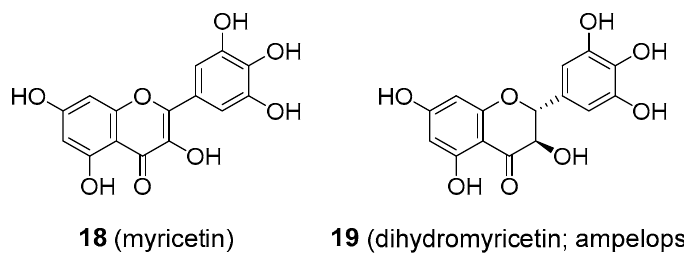
Figure 3. Molecular structures of myricetin and its analogue.